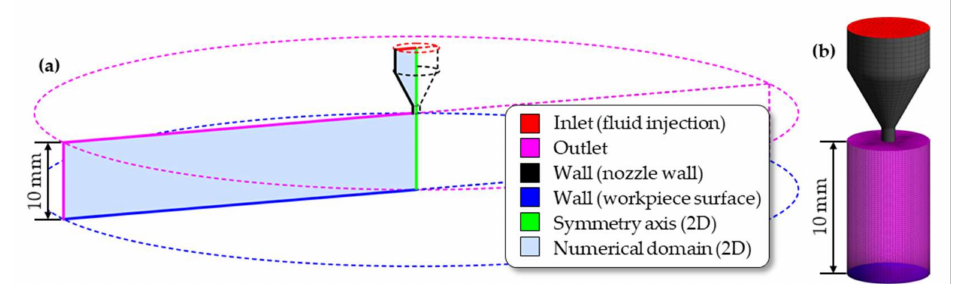
Figure 4. Numerical domain of the ( a ) 2D axisymmetric approach and ( b ) fully 3D domain of the FJP process.